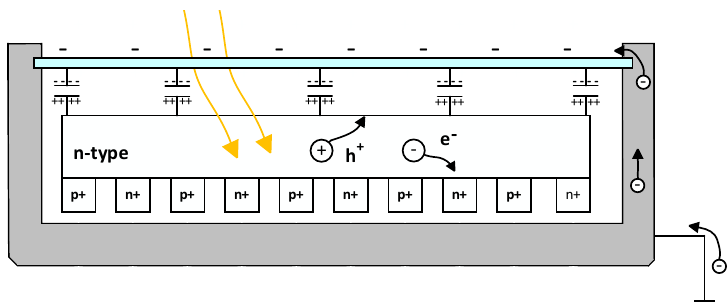
Figure 2. A cross-section of an n-type PV panel that is losing electrons due to PID.